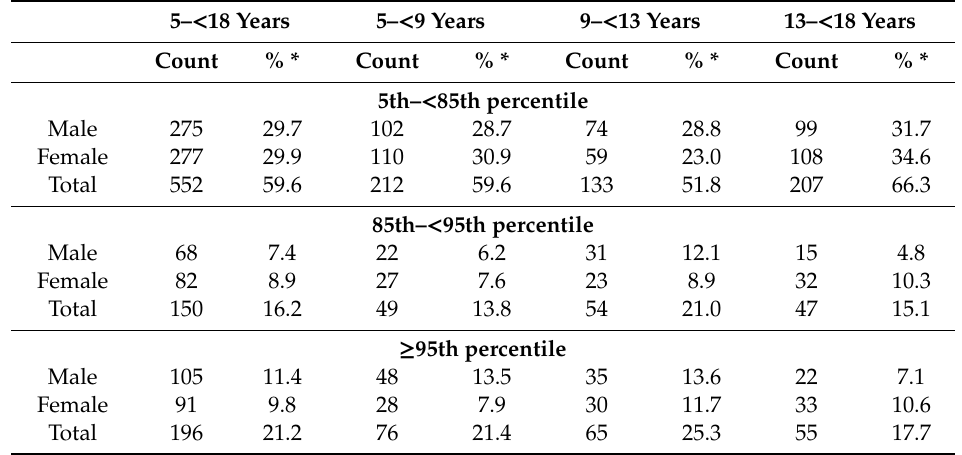
Table 3. Body Mass Index (BMI) percentiles by age and gender of children who were patients at a pediatric emergency department